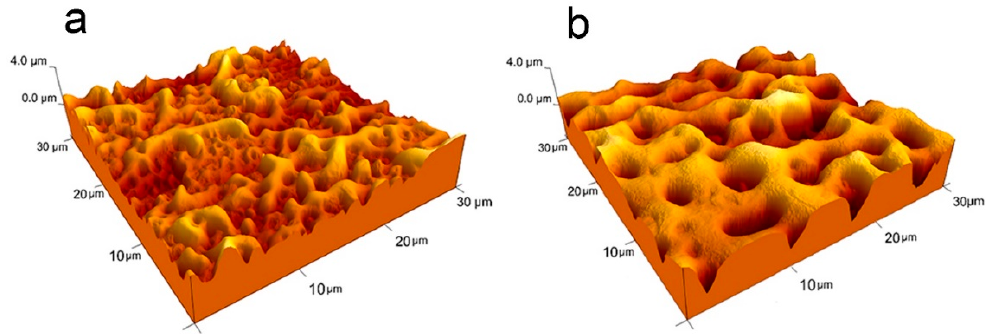
Figure 2. 3D visualization of typical 30 µm × 30 µm (4 µm z-scale) AFM images of ( a ) Nb200V60s and ( b ) Nb250V60s samples.